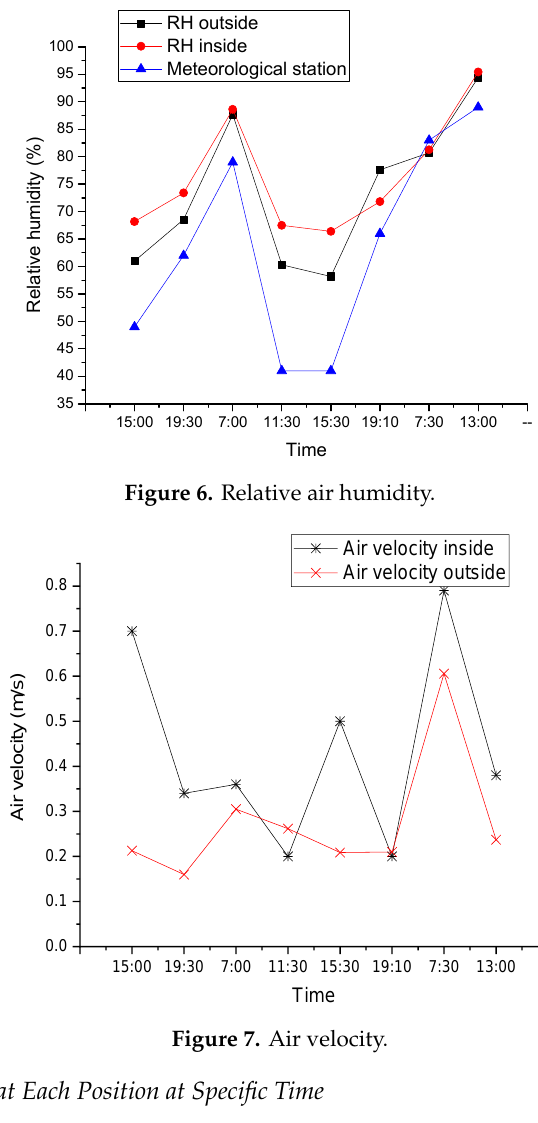
Figure 7. Air velocity.